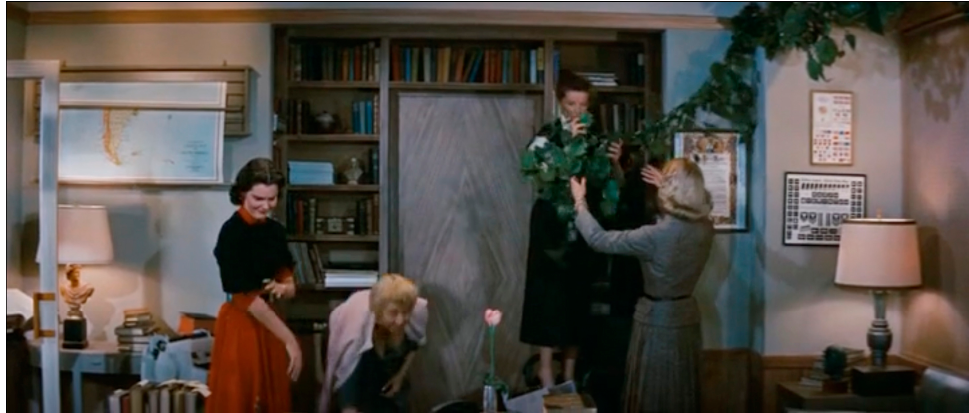
Figure 4. Bunny and her colleagues take down the philodendron.